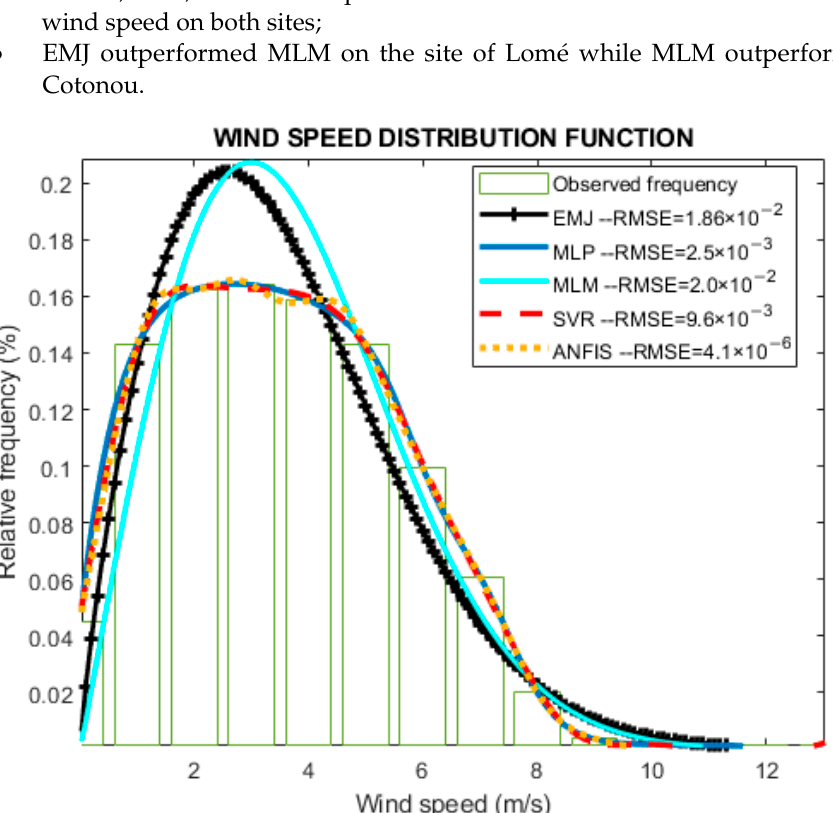
Table 9. Distribution area.